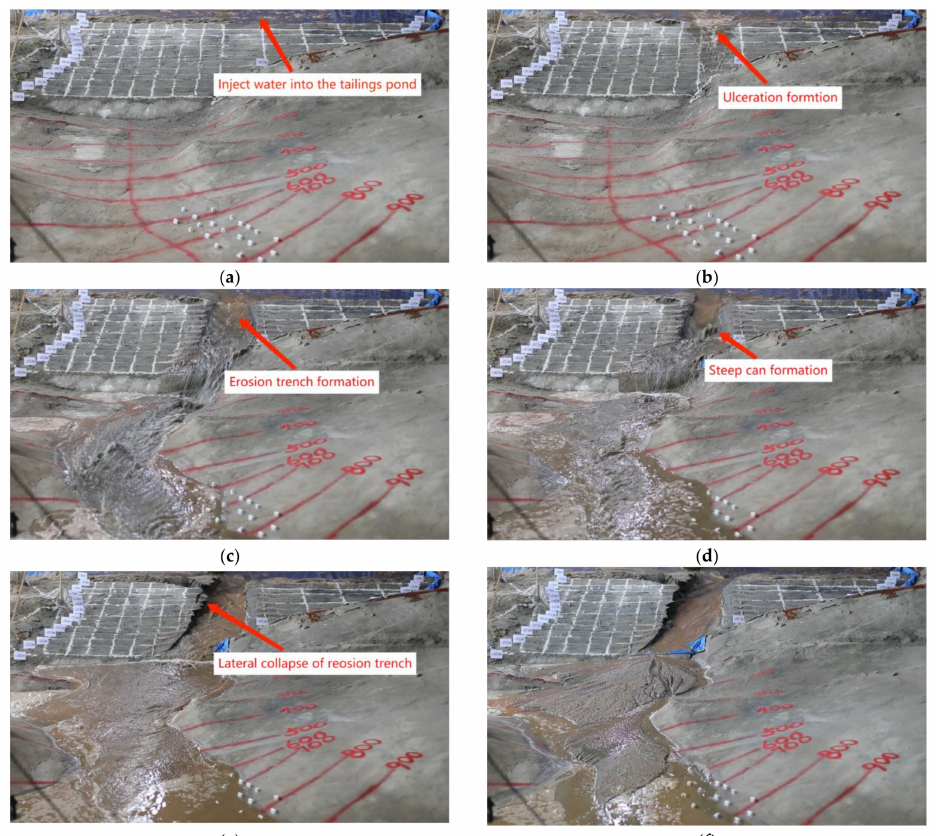
Figure 5. Dam breach process. ( a ) Water injection in the tailings pond. ( b ) Ulcer formation. ( c ) Erosion trench formation. ( d ) Steep can formation. ( e ) Erosion trench horizontal development. ( f ) End of dam